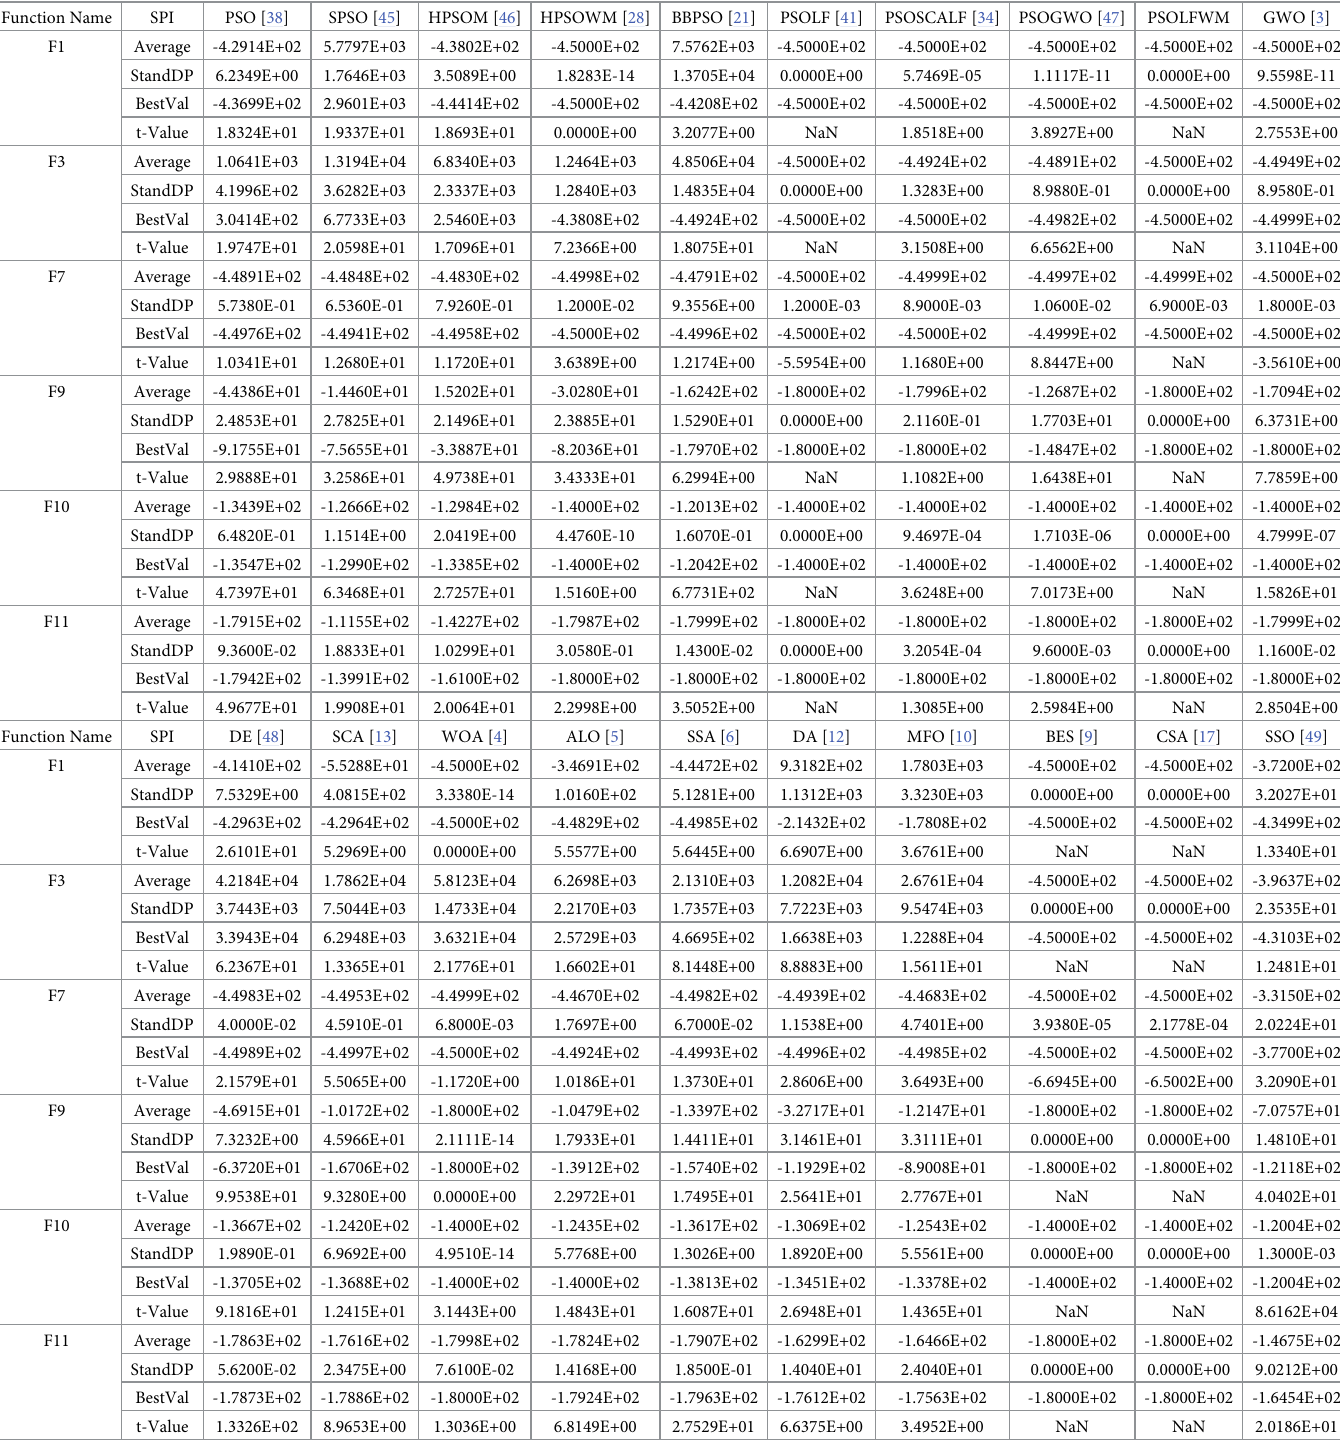
Table 9. Comparison results of dynamic shift